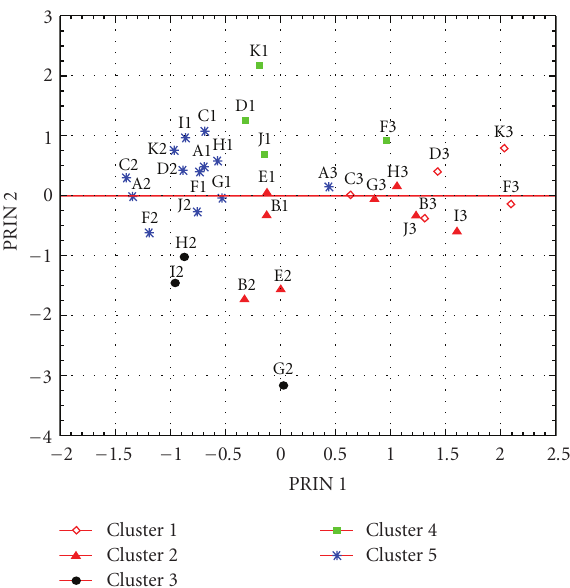
Figure 3: Graphic representation of hybrid behaviour according to first two principal components and identification of clusters for early sowing date (S2). Behaviour is represented by a letter (hybrid code) and a number (location-year